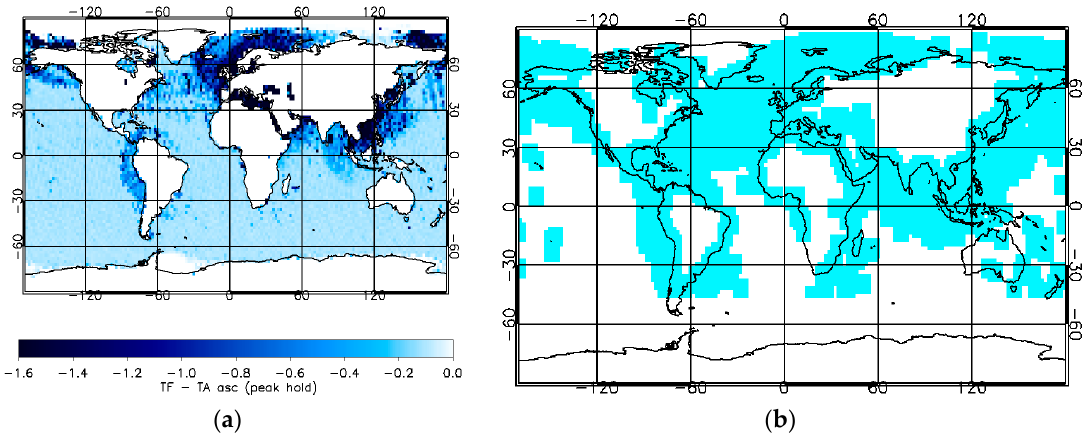
Figure 10. ( a ) RFI peak hold map: The map shows the largest monthly average value of the difference between RFI-filtered ( TF ) and unfiltered ( TA ) antenna temperatures over the time period SEP 2011–AUG 2014 of the ascending Aquarius swath. In producing the figure we have averaged over all 3 horns. ( b ) RFI mask for the ascending Aquarius swath: The map is obtained from the peak-hold map in ( a ) by taking all cells for which | TF − TA | > 0.2 K and then extending this area by ± 4 ◦ . This mask indicates the geographical area where undetected RFI might be